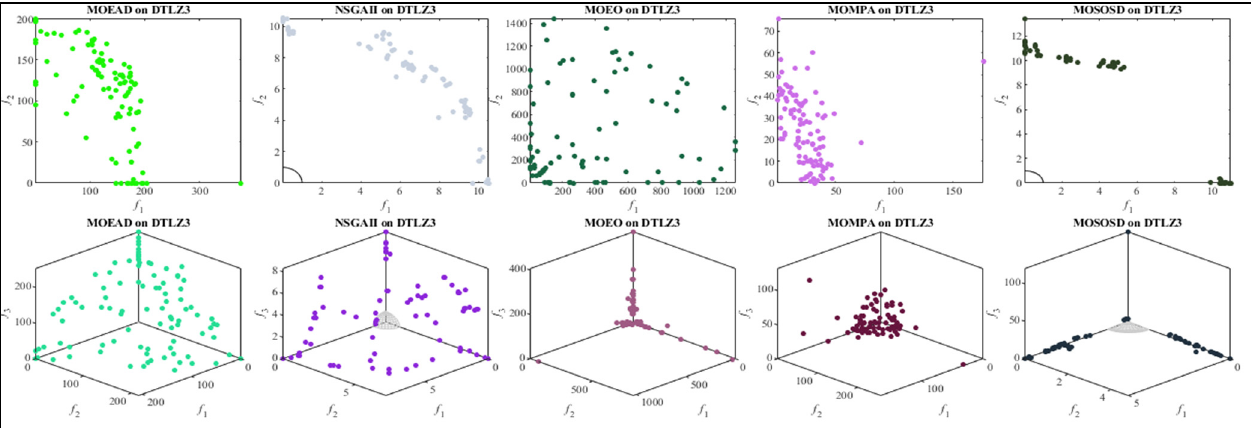
Figure 4. The Pareto front for DTLZ3 using various algorithms at 𝑀 = 2, 3 .